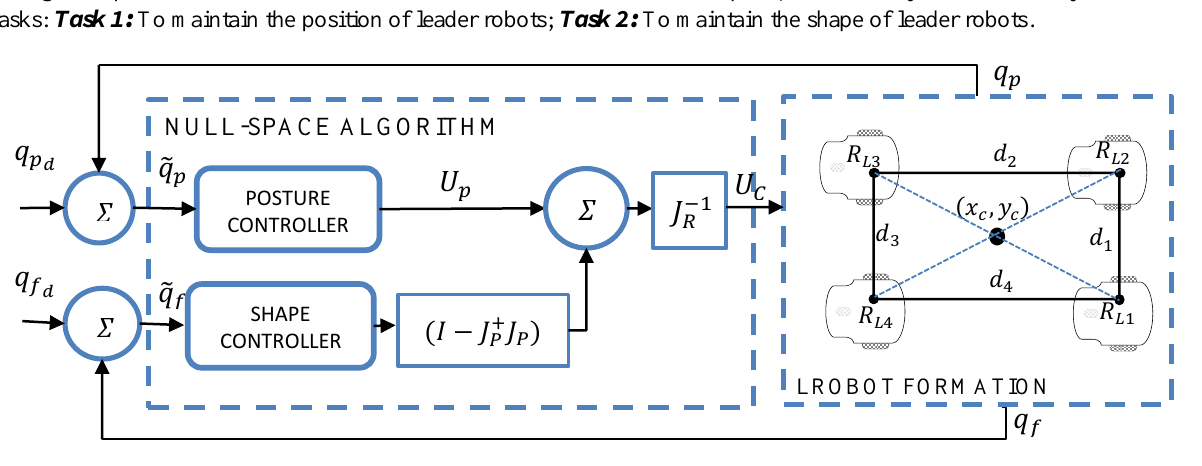
Figure 3. Null-space control